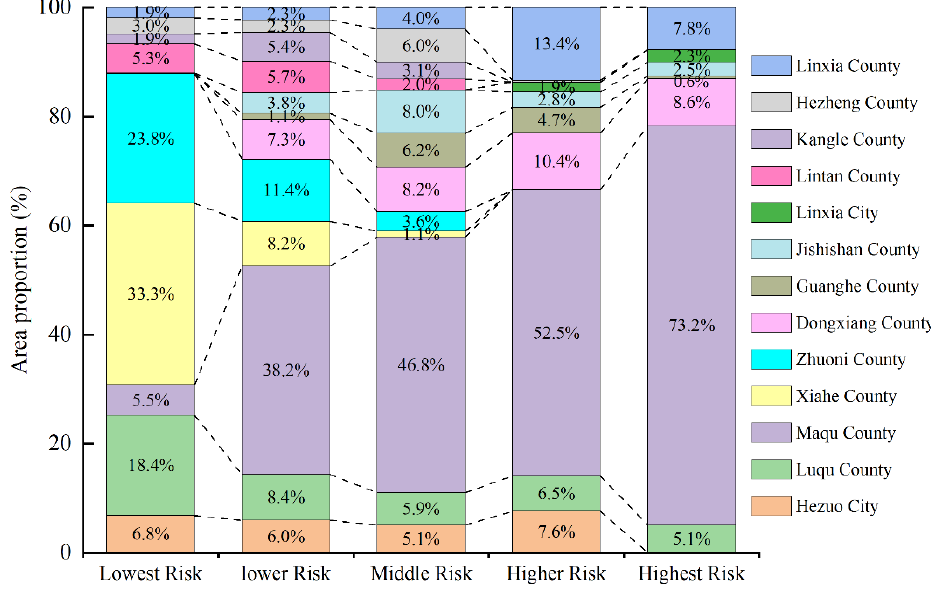
Figure 7. The proportion of the area of the five risk levels in each county (city) in 2018.